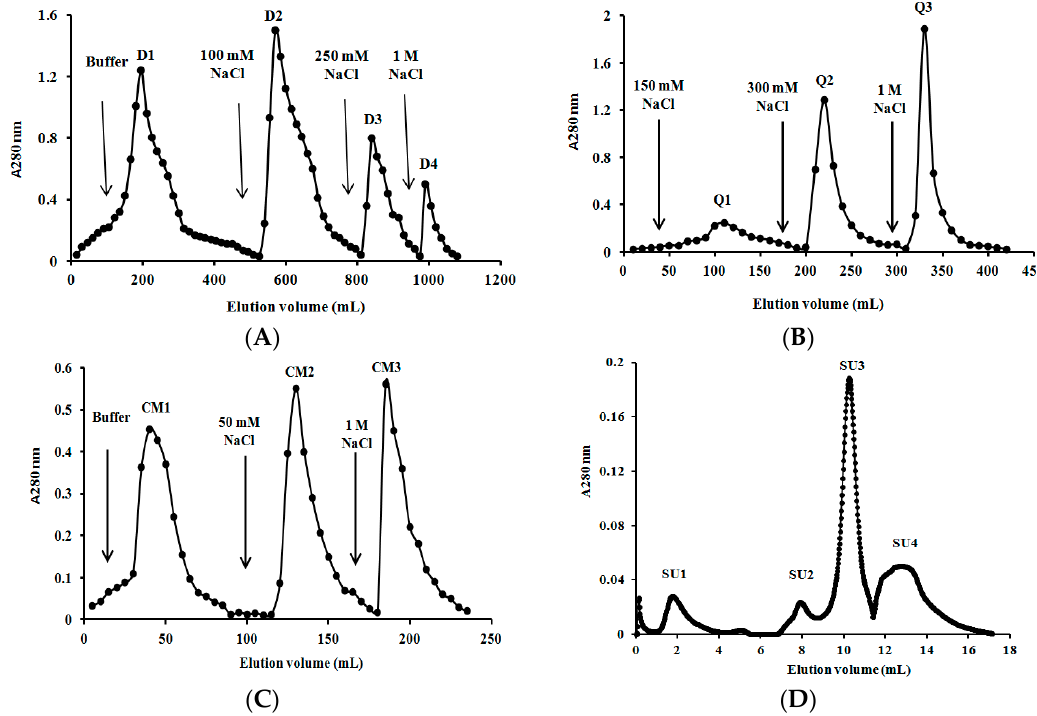
Figure 3. ( A ) Ion exchange chromatography on a DEAE-cellulose column. Sample: Proteins derived from fermentation broth of Lepista nuda. Laccase activity resided in fraction D3; ( B ) Ion exchange chromatography on Q-Sepharose column. Sample: Fraction D3 derived from DEAE-cellulose. Laccase activity resided in fraction Q2; ( C ) Ion exchange chromatography on CM-cellulose column. Sample: Fraction Q2 derived from Q-Sepharose. Laccase activity resided in fraction CM2; ( D ) Gel filtration by fast protein liquid chromatography on a Superdex 75 HR 10/30 column using an AKTA Purifier System. Sample: fracton CM2. Flow rate: 0.5 mL per minute. Laccase activity was enriched in fraction SU3. Table 1. Yields and laccase activities of various chromatographic laccase-enriched fractions from Lepista nuda laccase (assay conducted at 25 ˝